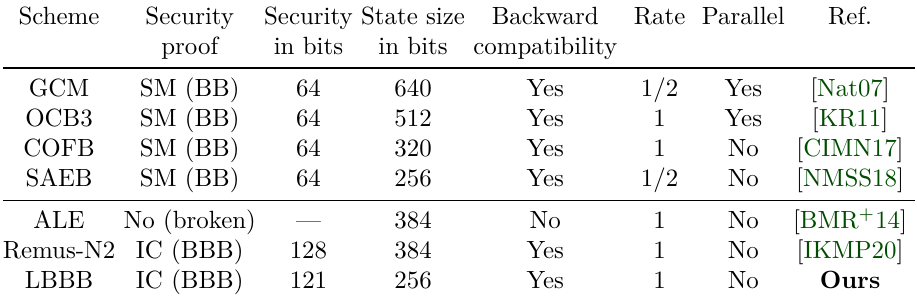
Table 1: Comparison of the Properties of the Schemes. The underlying block ciphers are AES-128. SM and IC mean that the security is proven in the standard model and in the ideal model, respectively. BB and BBB mean birthday-bound security and beyond-birthday- bound security, respectively. Backward compatibility shows whether AES coprocessor is used or not. Rate shows a reciprocal of the number of the underlying primitive calls per 128-bit plaintext, which is asymptotic. Note that ALE does not require KSF − 1 whereas other schemes require KSF − 1